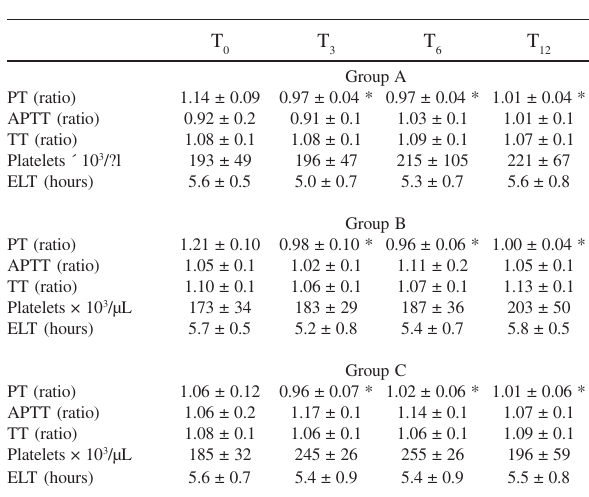
Table 2 - Results (mean ± standard deviation) of PT, APTT, TT, platelet count, and euglobulin lysis time during one year of hormone therapy in patients receiveing oral CEE (group A), oral CEE plus MP (group B), or transdermal 17 β - estradiol plus MP (group